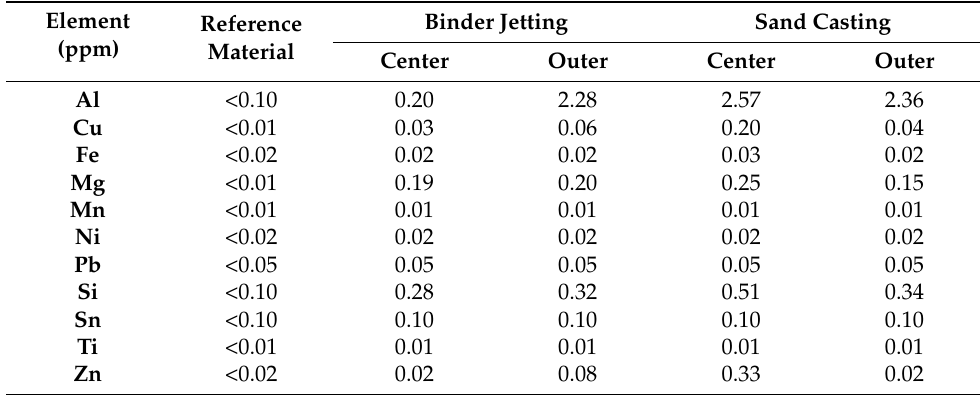
Table 7. Concentration (wt.%) of the elements in the 3.5% NaCl after 75 days of